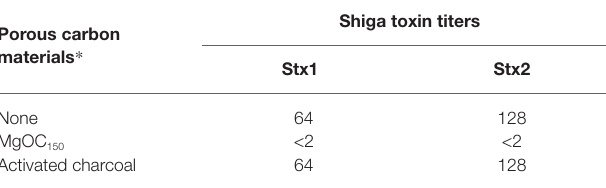
TABLE 1 | Shiga toxin titers after adsorption by porous carbons. Porous carbon materials